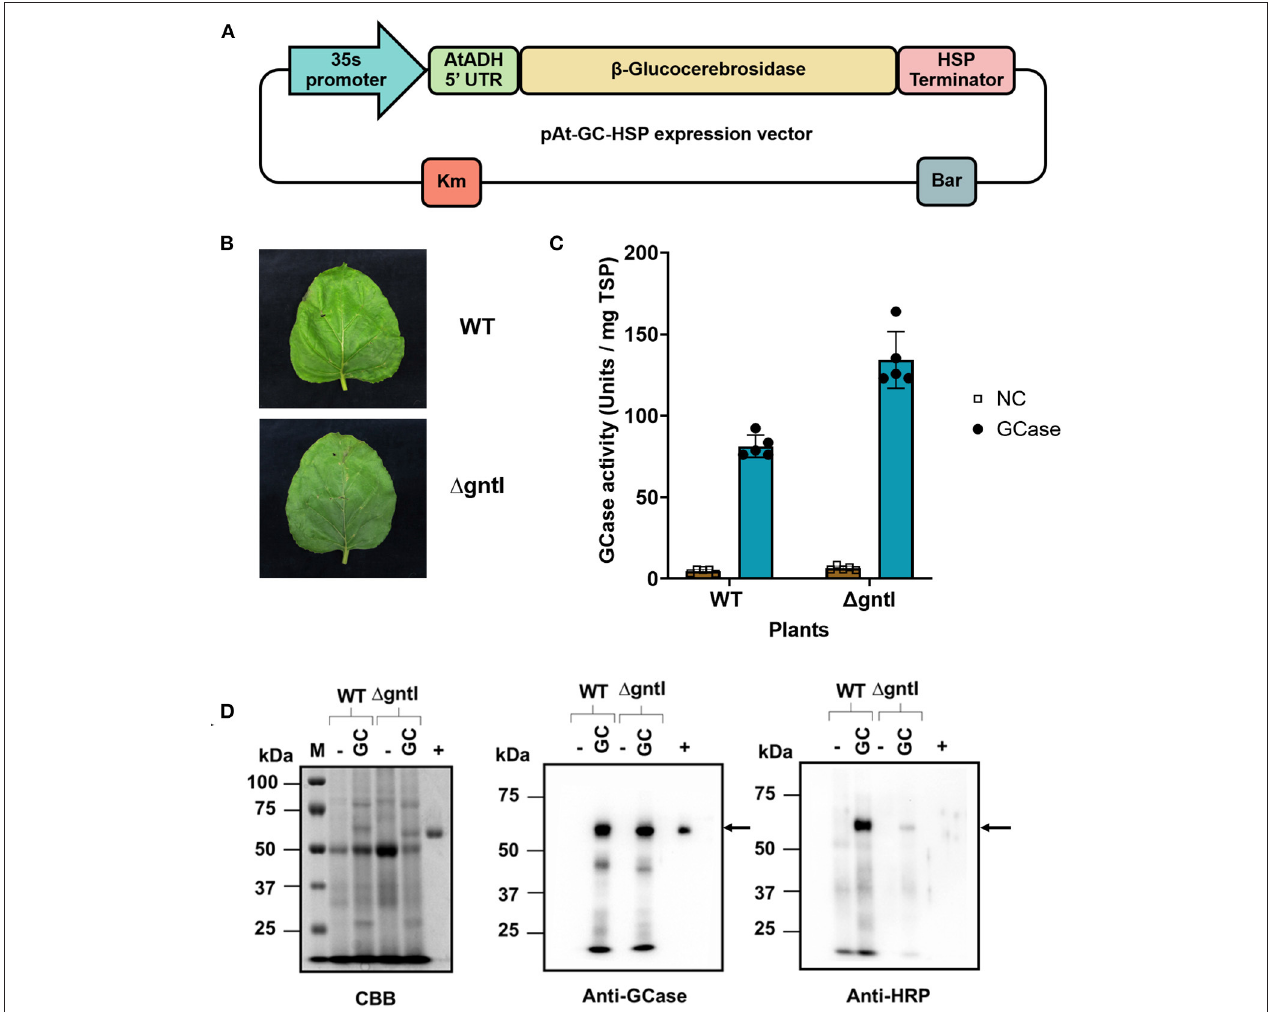
FIGURE 1 | Transient production of recombinant GCase in wild-type (WT) and 1 gntI N. benthamiana plants. (A) The pAt-GC-HSP expression vector. 35S promoter: Cauliflower mosaic virus 35S RNA promoter; AtADH 5’UTR: 5’-UTR of Arabidopsis alcohol dehydrogenase (AtADH) gene; β -Glucocerebrosidase: β -glucocerebrosidase gene; HSP terminator: Transcription terminator from A. thaliana heat shock protein; Bar: bialaphos resistance gene; Km: Kanamycin resistance gene. (B) Infiltrated leaves and (C) GCase activity of crude protein from infiltrated WT and 1 gntI leaves at 7 days post-infiltration. NC: non-infiltrated leaves (negative control). The experiment was performed in five replications. Error bars represent the standard deviation (SD). (D) Total soluble protein: 10, 5, and 1 µ g were loaded and analyzed by Coomassie Brilliant Blue (CBB) staining, anti-GCase blotting, and anti-HRP blotting, respectively. M, Precision Plus Protein standards marker;